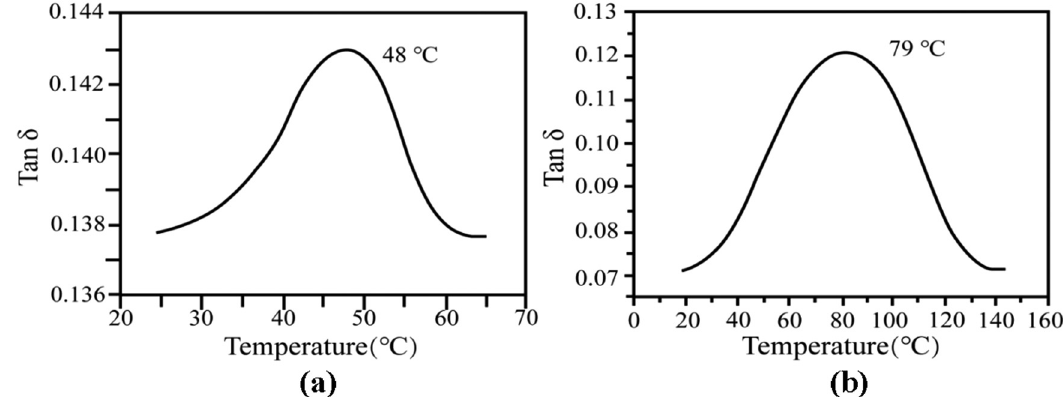
Figure 5: Glass transition temperature ( T g ) test for PET and bio - based PA56 using DMA method for ( a ) PET and ( b ) bio - based